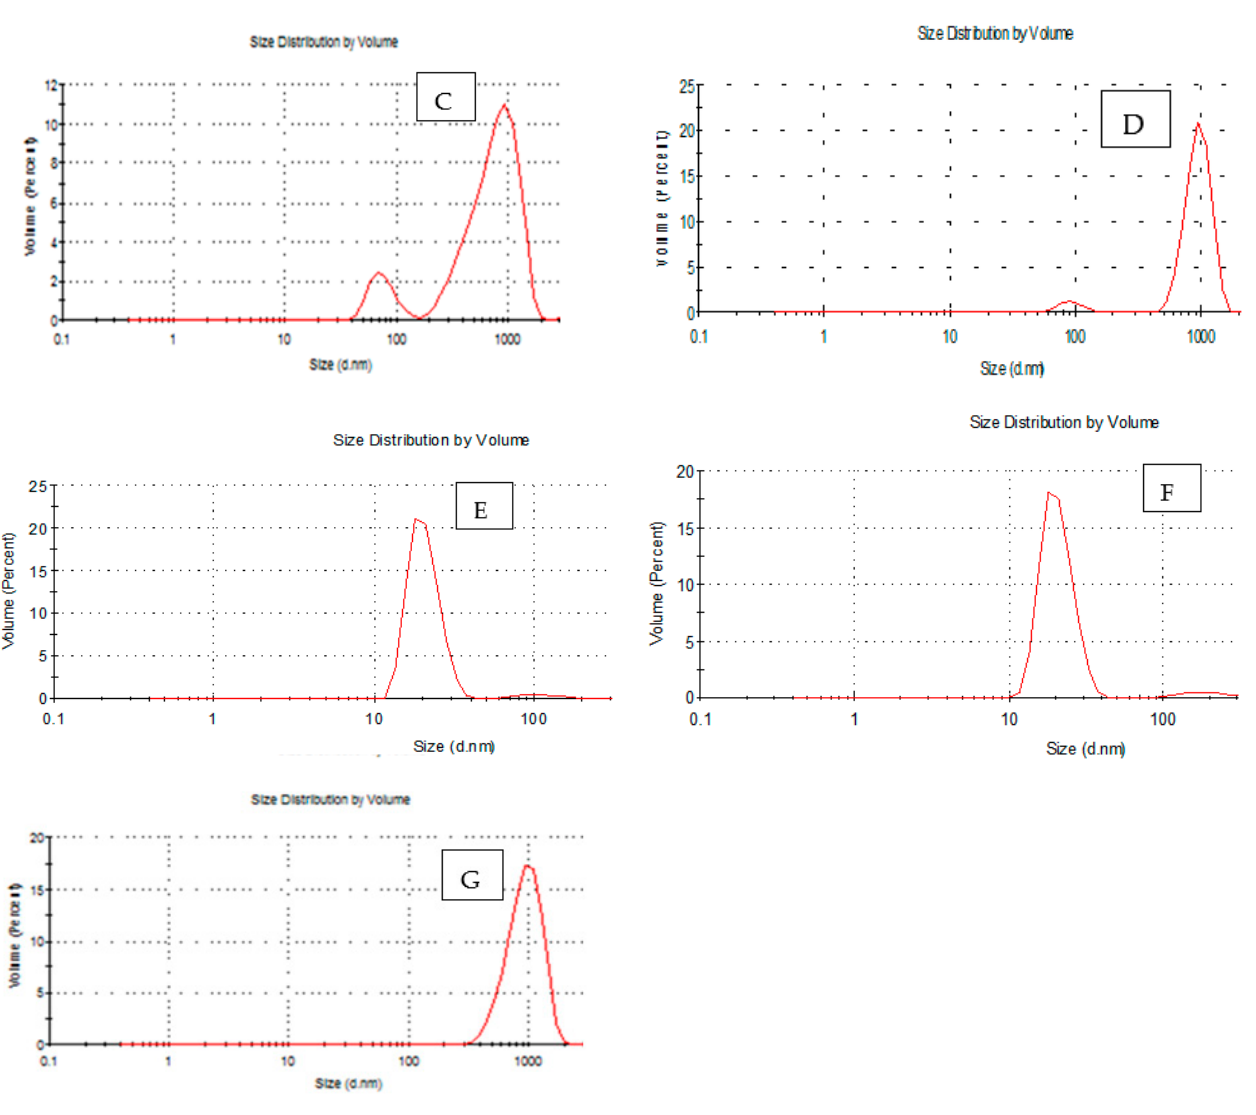
Figure 2. Partical size of prepared nano-edible coatings and films combined with ZnONPs and ZnONPs/EPP to produce an edible film-forming suspension solution of different treatments. ( A ) = PPE extracts, 5% (0.1%) wt% chitosan ( B ) = ZnONPs, 1% (0.02%) wt% chitosan ( C ) = ZnONPs, 2% (0.04%) chitosan ( D ) wt% = ZnONPs, 3% (0.06%) wt% chitosan weight ( E ) = ZnONPs 1%/PPE1% (0.02%) ZnONPs 2%/PPE2% (0.04%) chitosan weight ( F ) chitosan weight ( G ) = ZnONPs 3%/PPE3% (0.06%) Chitosan weight n.s. stands for “not significantly”.